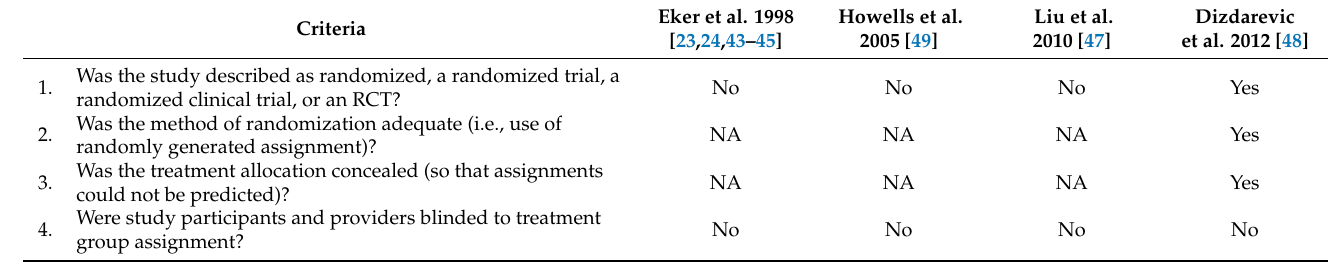
Figure 1. Meta-analysis of mortality in controlled clinical studies from Eker et al [23,24,43–45], Howells et al. [49], Liu et al. [47], and Dizdarevic et al. [48] comparing the intracranial pressure-targeted Lund concept treatment, including albumin infusion, with cerebral perfusion pressure-targeted therapy of severe traumatic brain injury in adults. A random effects model was used for the analysis. The size of the squares indicates the data points from the individual studies scaled according to the percentage of the total weight (with individual trial weights equaling the proportion of total patients receiving Lund concept treatment multiplied by the number of deaths in the cerebral perfusion pressure-targeted group), and the diamond indicates the pooled findings. The dashed line indicates pooled relative risk. The proportion of the variation attributable to heterogeneity (I2) was 38.6% (95% CI, 0.0–79.0%). CPP, cerebral perfusion pressure; CI, confidence interval. Table 4. Risk of bias assessment of the studies in the meta-analysis using the NIH National Heart, Lung, and Blood Institute Quality Assessment of Controlled Intervention Studies [46]